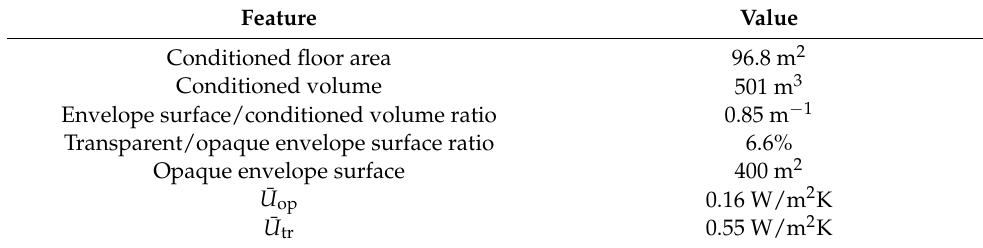
Table 3. Main features of the facility